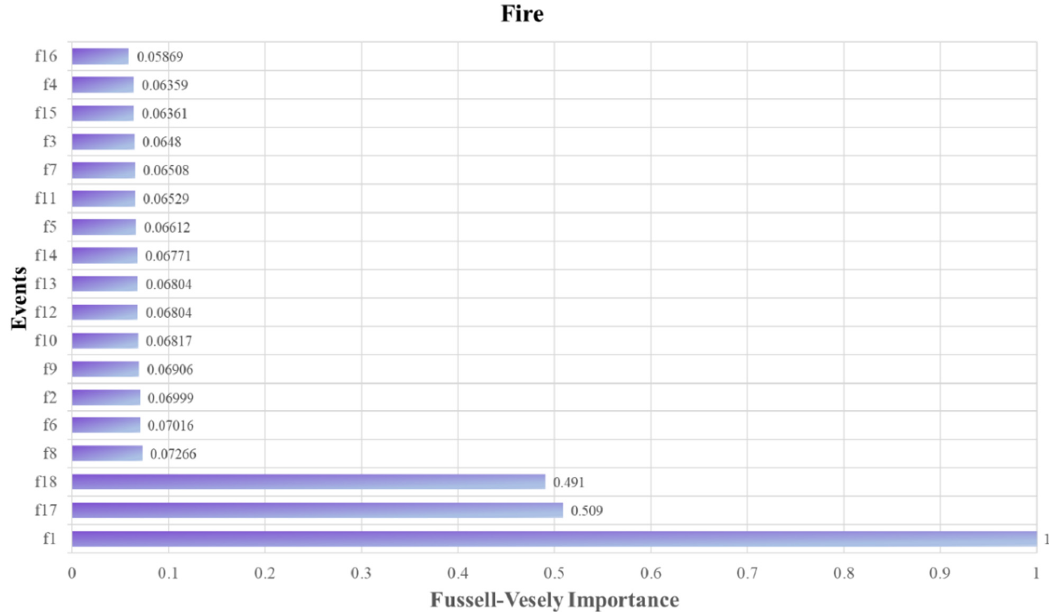
Figure 10. Fussell–Vesely Importance of each basic event of the fire accident. (2) Risk assessment of lightning With the help of Isograph Reliability Workbench, the minimum cut set, structural importance degree, and probability importance degree of the lightning accidents are pre- sented underneath. There are 45 minimum cut sets of lightning accidents: